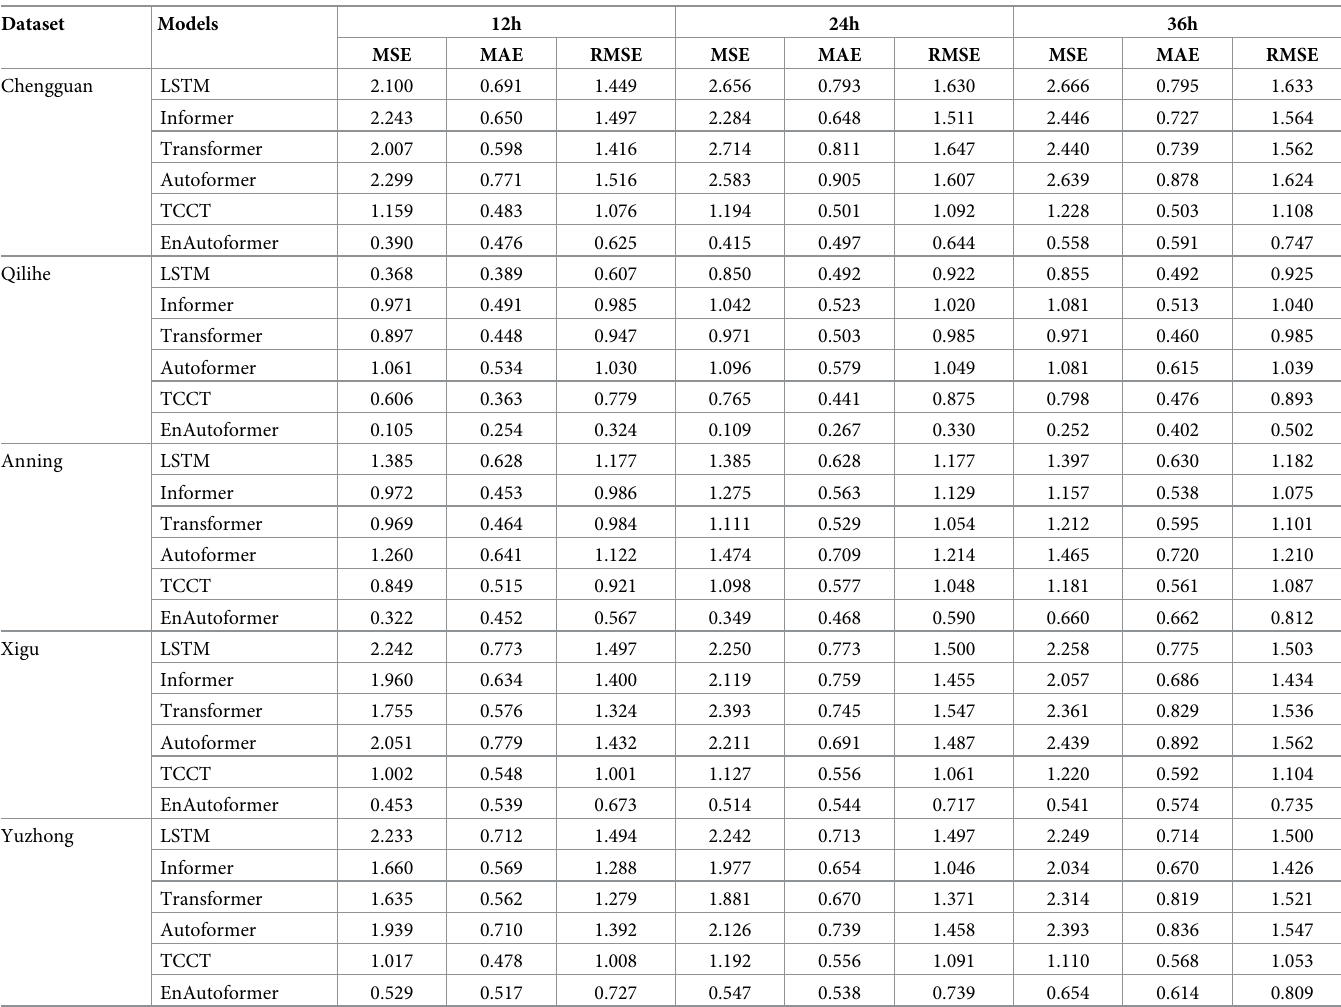
Table 5. Performance comparison of different prediction